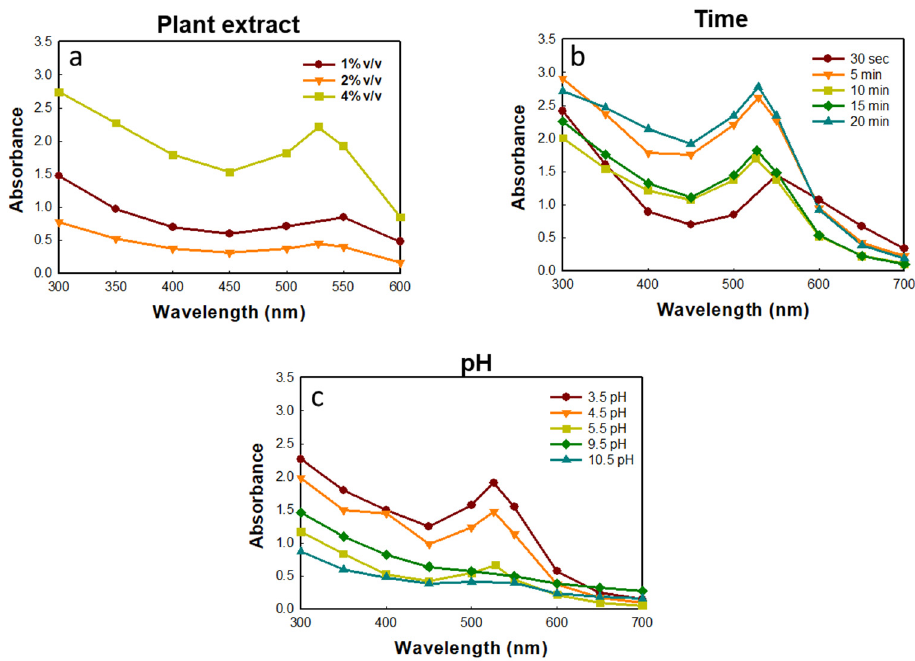
Figure 2. Optimization of GP-AuNP synthesis using different plant extract ( a ), time ( b ), pH ( c ).